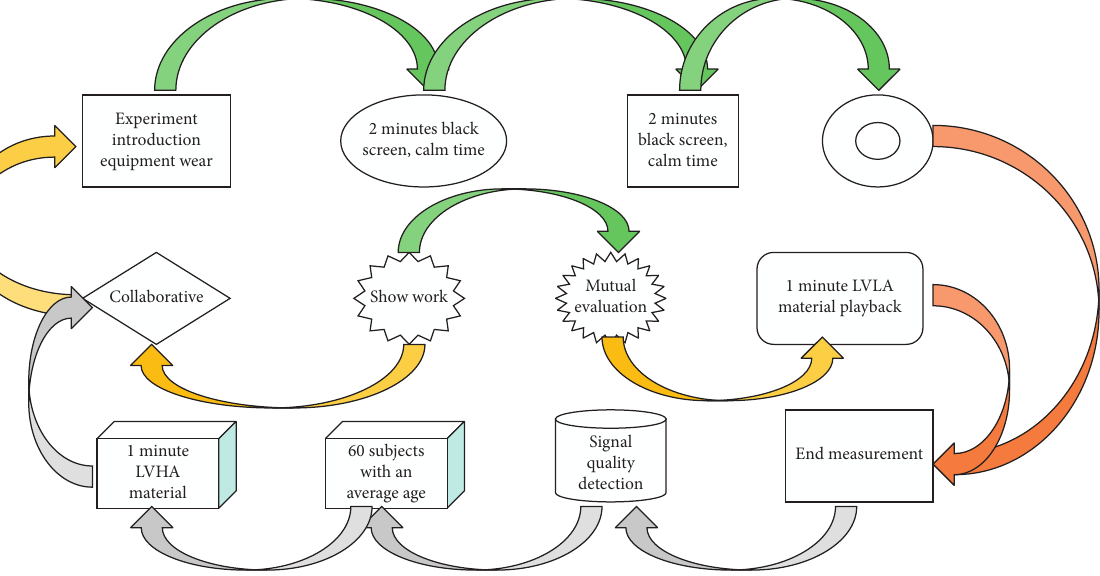
Figure 4: Experimental flowchart.